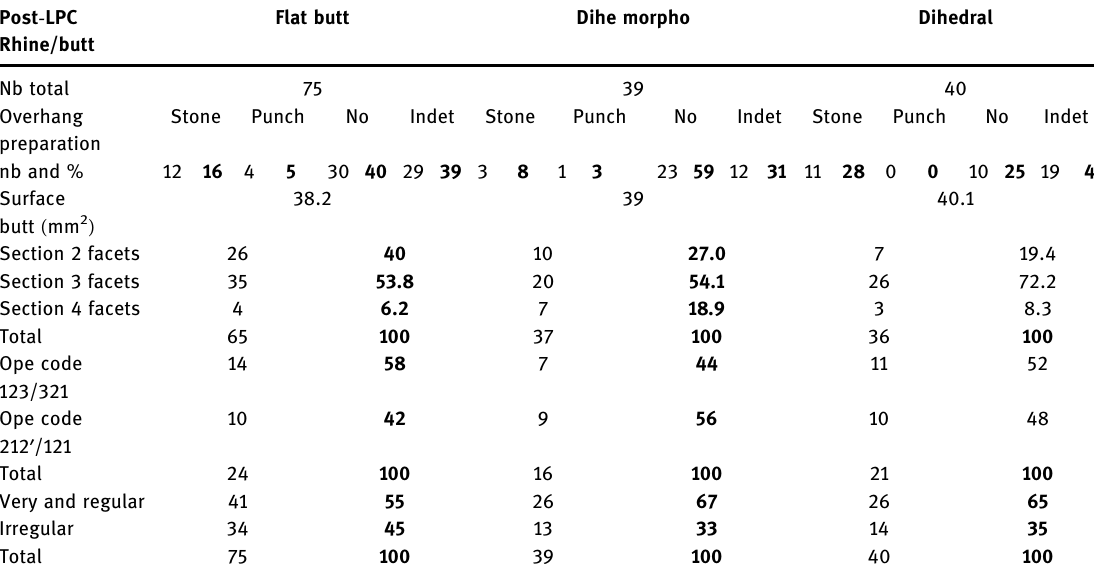
Table 8: Summary indicating the descriptive technical criteria of the blades according to the techno - morphology of their butts, all sites from the German Rhineland, eastern